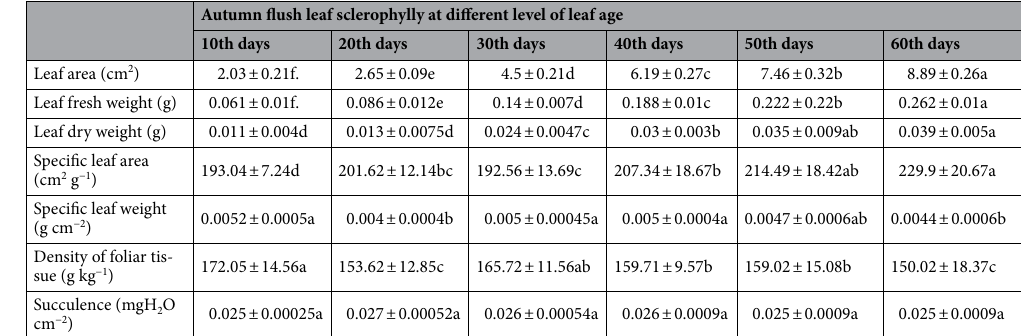
Table 10. Leaf sclerophylly parameters of autumn flush. Results were reported in means (± SD). Means sharing dissimilar letters are significantly differed according to LSD test ( P ≤ 0.05) for three flushes leaves aged (10–60 days) in Tables 8, 9 and